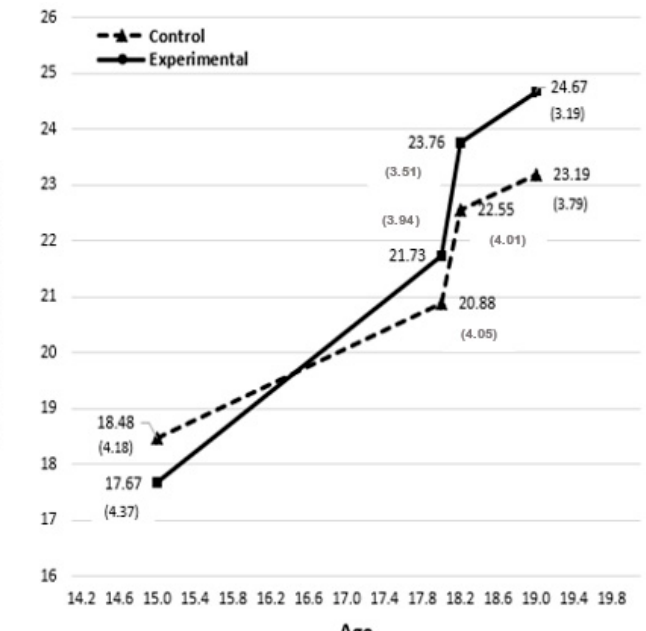
Figure 1. Arithmetic means over 28 cognitive tests from Stankov’s (1986, Table 1) at the Initial (age 15), Final (age 18), 1st Retest (age 18.3), and 2nd Retest (age 19) occasions. Standard deviations are in brackets.